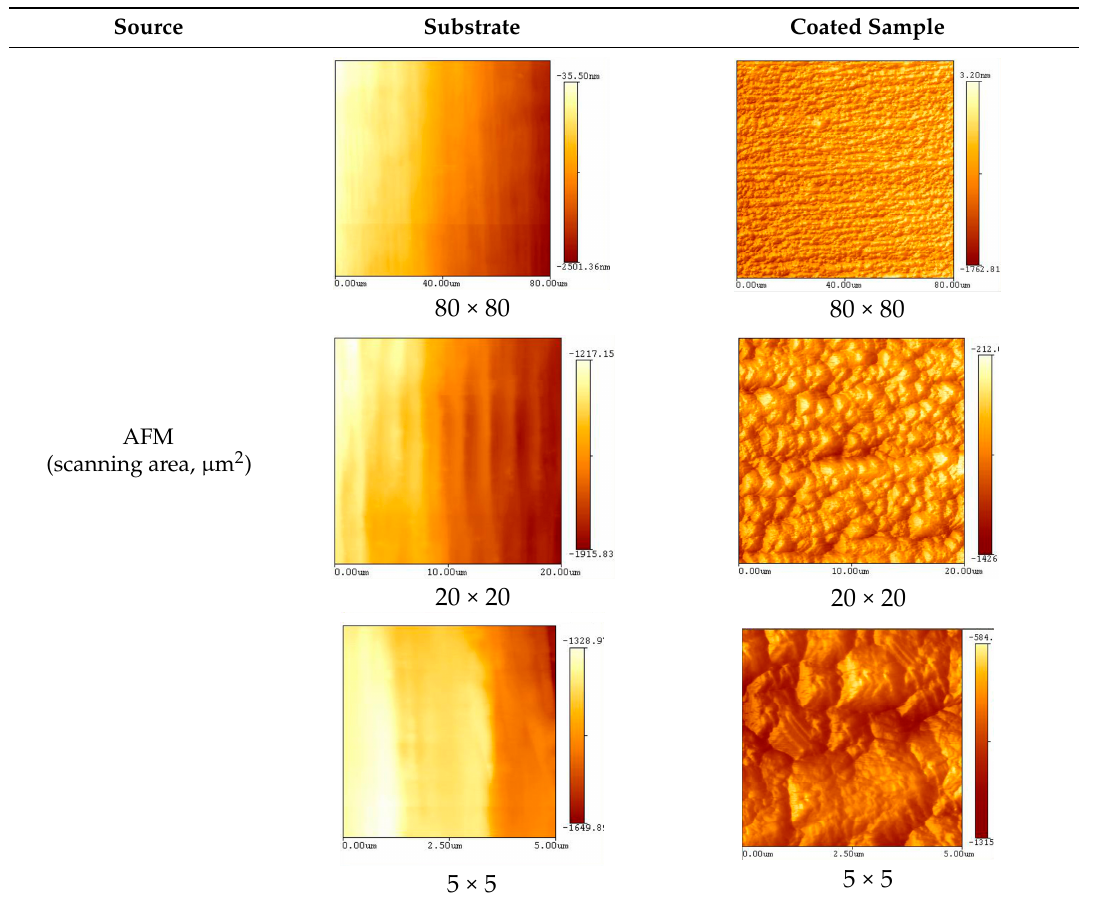
( c ) Figure 3. Microimage of the original molybdenum plate cross ‐ section after etching: ( a ) optical microscope, ( b ) AFM area 5.93 μ m × 5. 93 μ m, ( c ) AFM area 1.14 μ m × 1.14 μ m. As can be seen from the images obtained using an optical and atomic force microscope, the initial molybdenum substrates had a rolled structure with longitudinal deformation bands (see Table 2). Table 2. Micrographs of a flat molybdenum plate before and after the electrochemical synthesis of the Mo 2 C coating obtained on optical and atomic force microscopes. Source